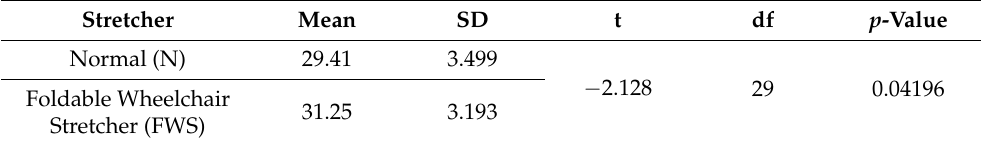
Table 14. Paired sample t -test for test